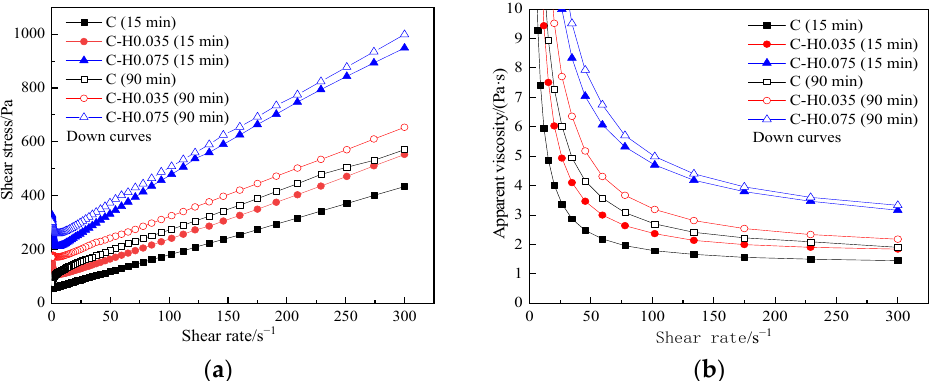
Figure 10. Rheological curves of C-HPMC pastes. ( a ) shear stress vs. shear rate, ( b ) apparent viscosity vs. shear rate.